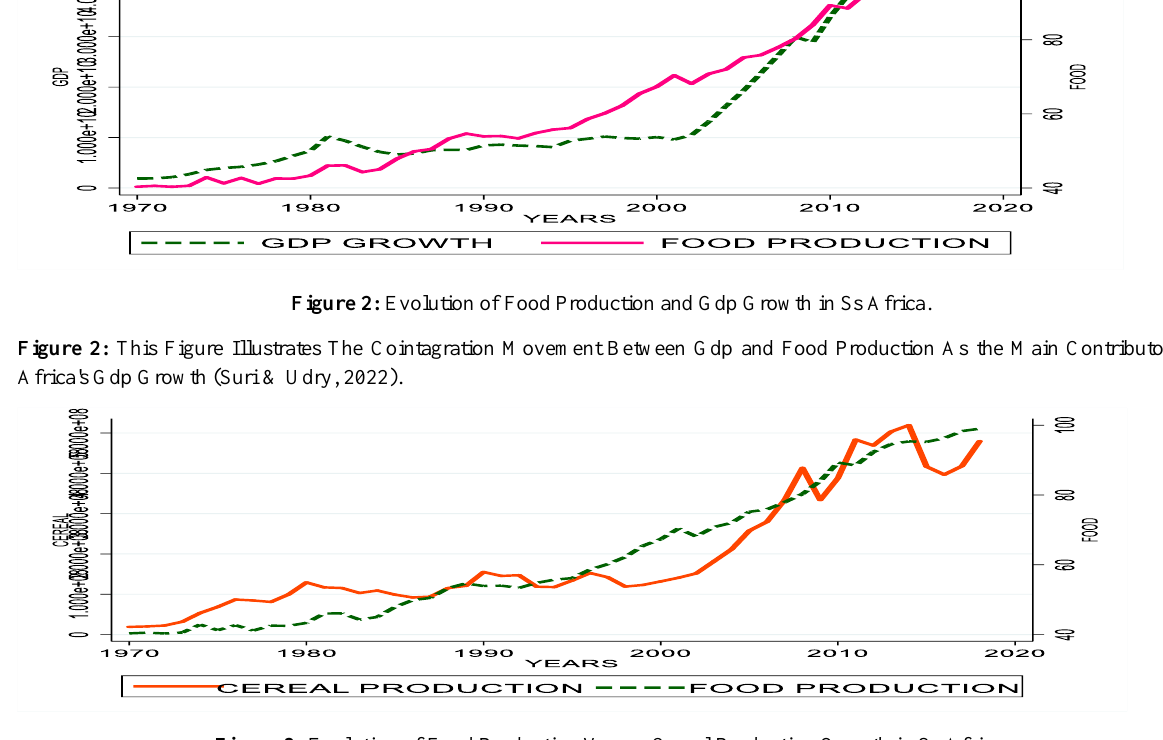
Figure 3: Evolution of Food Production Versus Cereal Production Growth in Ss Africa. Figure 3: This Figure Illustrates the Cointegration Movement Between Cereal and Food Production as the Main Contributors to Africa's GDP